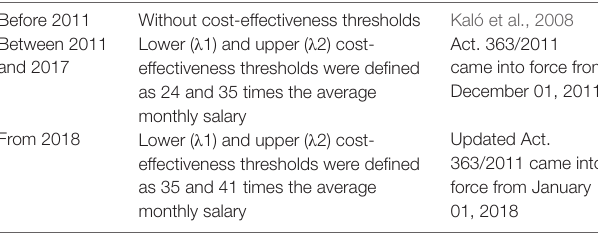
TABLE 2 | Cost-effectiveness thresholds in the Slovak